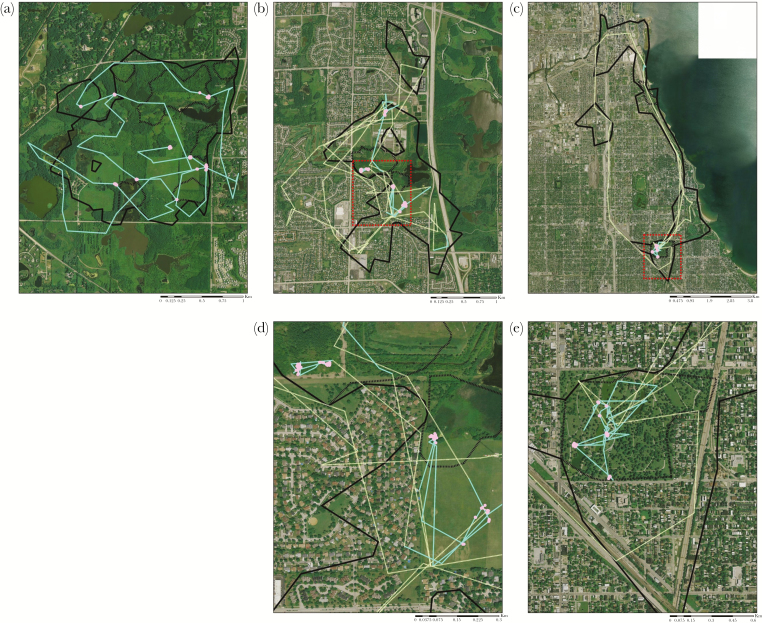
Examples of 2-day windows of movement behavior for 3 coyotes (Canis latrans) in the Chicago metropolitan area, USA, from 2008 to 2017. We distinguished only 2 movement behaviors, encamped (pink dots) and moving (blue lines), for coyotes living in natural fragments in the urban landscape (a). For coyotes living in suburban (b) and highly urbanized landscapes (c), we were able to distinguish 3 movement behaviors: encamped (pink dots and lines), foraging (blue lines), and traveling (dashed yellow lines). (d) A zoomed in map of (b), and (e) a zoomed in map of (c), indicated by red squares. Coyote home ranges (95% local convex hull; solid black line) and core ranges (50% local convex hull; small dashed black line) are included for reference.